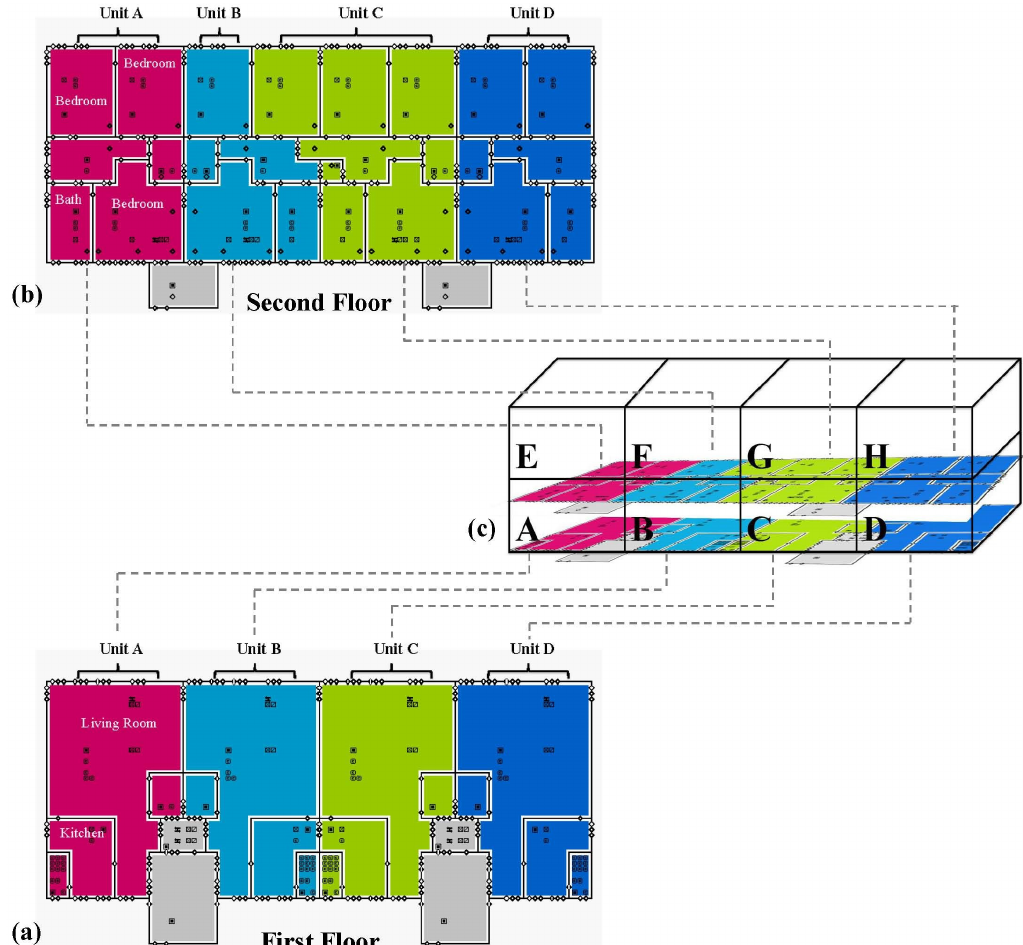
Figure 1. CONTAM building schematic representing the first and second floors of a typical 4-story townhouse building. The building has 8 townhouses total (4 across and 2 up), on a total of 4 floors.